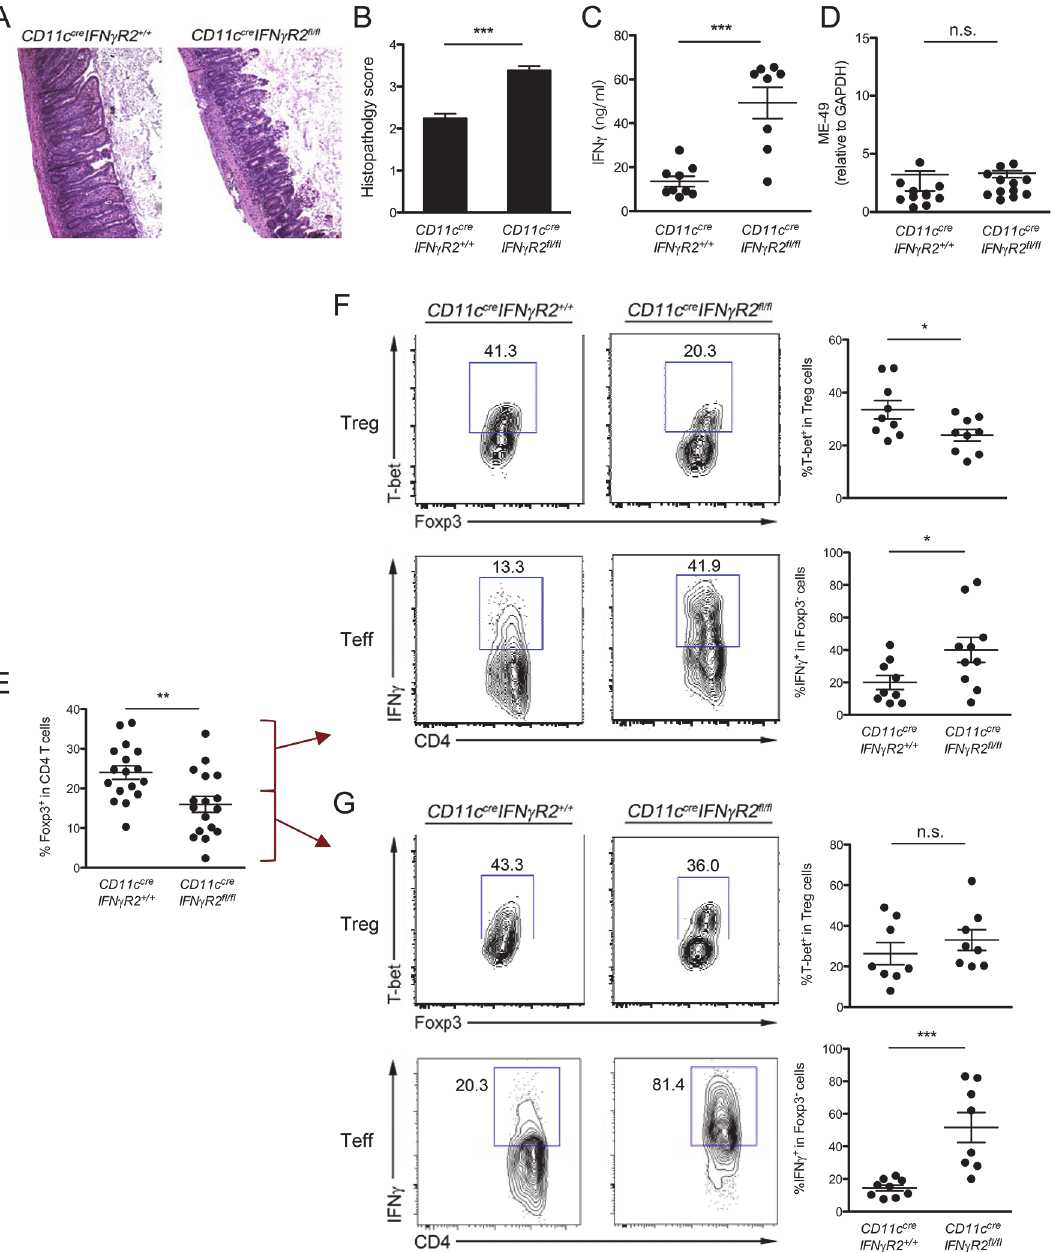
Fig 4. Reduced T-bet + Th1-Treg cells in CD11c cre IFN γ R2 fl/fl mice resulted in unrestrained IFN γ -mediated Th1 inflammation during T . gondii infection. (A,B) Histological assessment of ileum from infected CD11c cre IFN γ R2 fl/fl and WT control mice (n = 12). (C) ELISA analysis of serum IFN γ levels and (D) PCR analysis of parasite burden in LP at days 8 after infection. (E) Frequencies of total Foxp3 + Treg cells from LP in CD11c cre IFN γ R2 fl/fl and WT control mice at day 8 post T . gondii infection. FACS analysis and frequencies of T-bet + cells in Foxp3 + CD4 + Treg cells and IFN γ + cells in Foxp3 - CD4 + Teff cells from LP in CD11c cre IFN γ R2 fl/fl (F) without or (G) with Treg cell collapse and their corresponding WT control mice at day 8 post T . gondii infection. FACS data are representative of three to four independent experiments. ( * p < 0.05; ** p < 0.01; *** p <